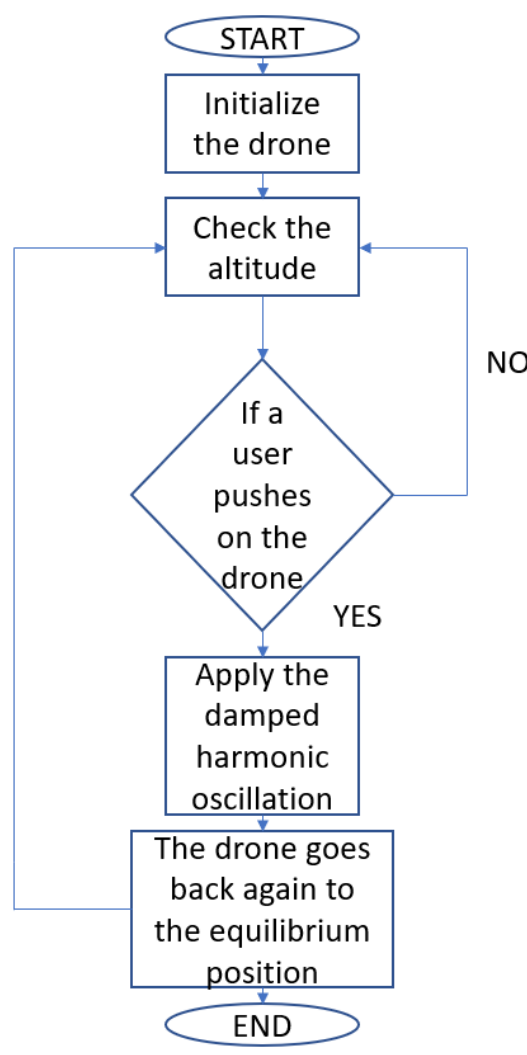
Figure 5 Flowchart (a) Drone takeoff initiated by mouse function.